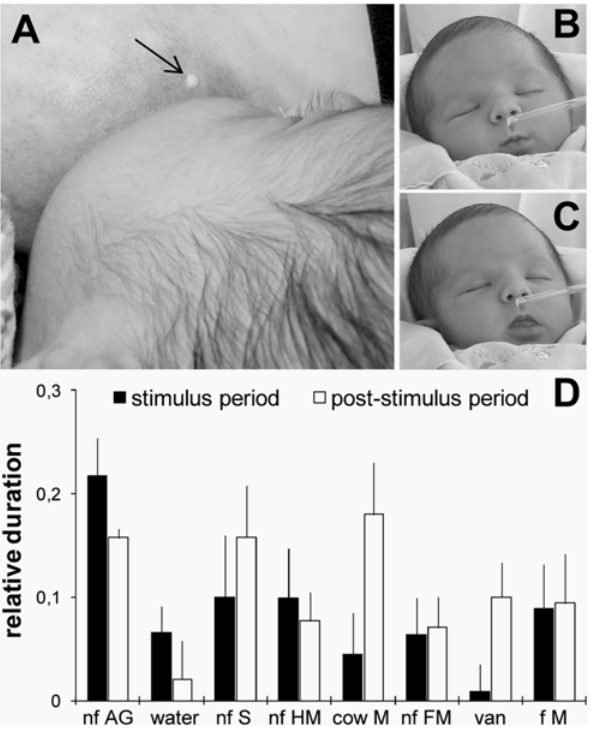
Figure 1. Areolar glands and infant behavior. A) Areola of a lactating woman (day 3 postpartum) with Montgomery’s glands giving off their secretion (arrow). B and C) Newborns’ oro-cephalic responses to the secretion of Montgomery’s areolar gland (B: lip pursing; C: tongue protrusion). D) Mean ( 6 sem) relative durations of newborns’ oro-cephalic responses during (10-sec stimulus period) and after (10-sec post-stimulus period) presentation of various olfactory stimuli (Abbre- viations: AG: secretions of areolar glands; S: sebum; HM: human milk; cow M: cow milk; FM: formula milk; van: vanillin; M: milk; f: familiar; nf: non-familiar;